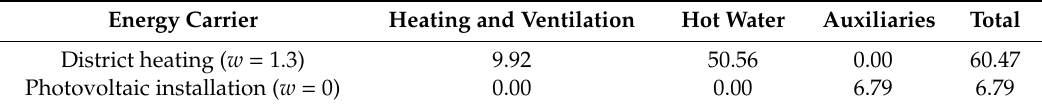
Table 20. The annual EK demand (kWh / (m 2 · year)) for the multi-family building at Akacjowa Street in Goleniow (district heating (Goleniow) + mechanical supply and exhaust ventilation with recovery + photovoltaic installation for auxiliary